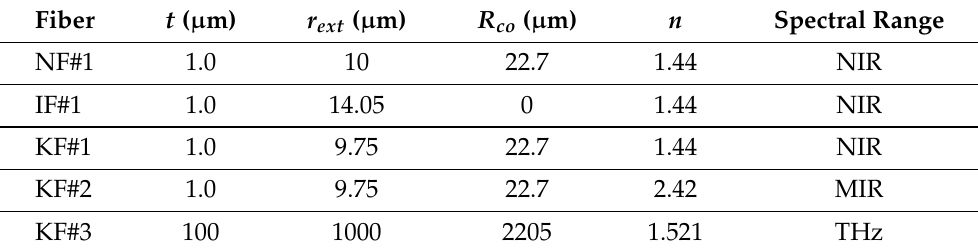
Table 2. Parameters of equivalent TLFs, used for the analysis of NF, IF, and